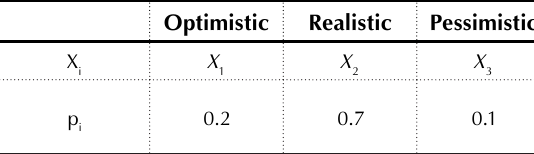
Table 3. Probability of implementation of the firm portfolio development